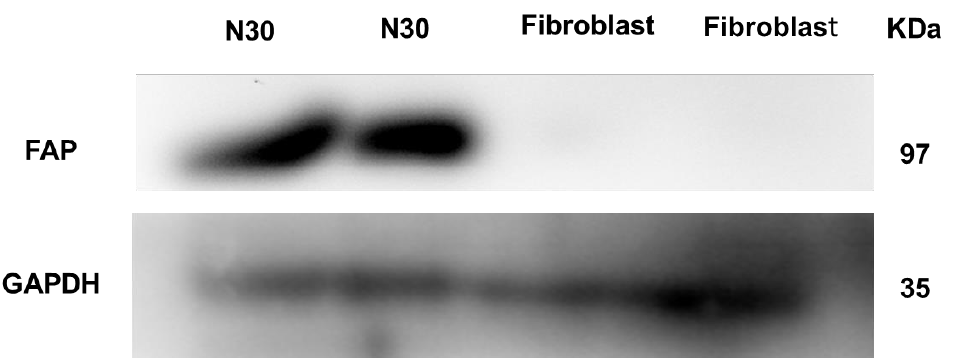
Figure 3. Western blot assay showing expression of FAP in N30 (primary human stromal endometrial cells) and negative FAP expression in human fibroblasts. GAPDH was used as a control.